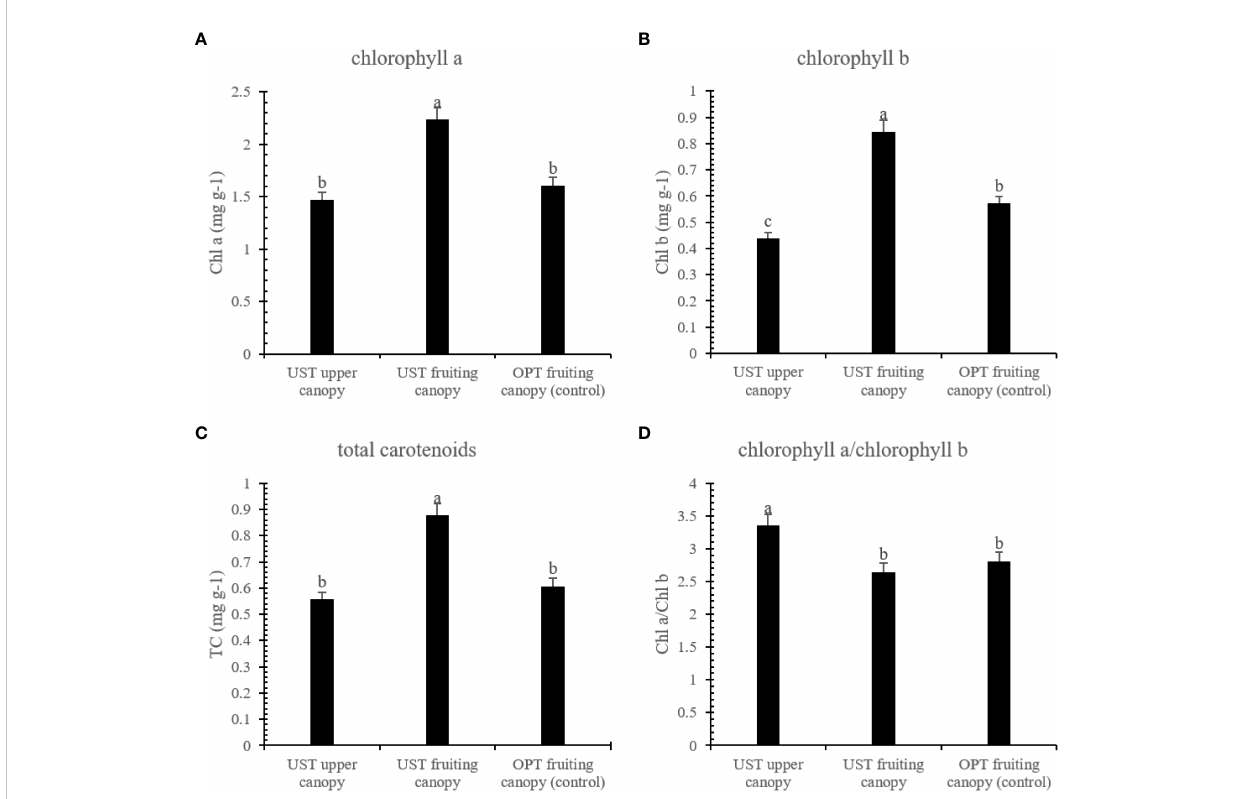
FIGURE 3 Effects of the OPT and UST on (A) chlorophyll a (Chl a), (B) chlorophyll b (Chl b), (C) total carotenoid (TC), and (D) chlorophyll a/chlorophyll b of Donghong kiwifruit. The lower-case letters on the bars indicate signi fi cant differences ( P < 0.05).